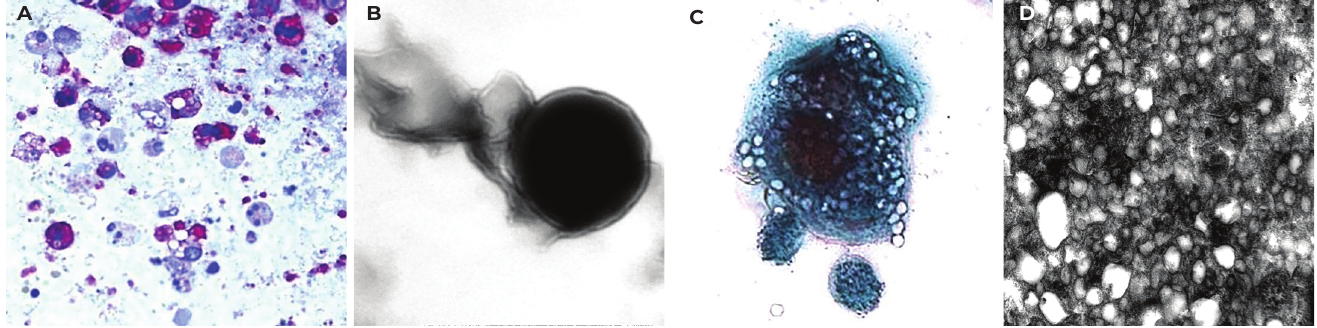
Figure 1 - Contents of echinococcal cyst 3 days after HIFU ablation. A - sedimentary material of echinococcal cyst contents. Semi-thin slice x 1000. B - necrosis of fine ultrastructure. Electronogram x 34,000. C - helicization and vacuolization of cytoplasm, detachment of protoscolex heads. Cytological smear preparation. Papanicolaou staining x 1 000. D - vacuolization of hyaloplasm and destruction of organelles in protoscolex cells. Electronogram x 24 000.